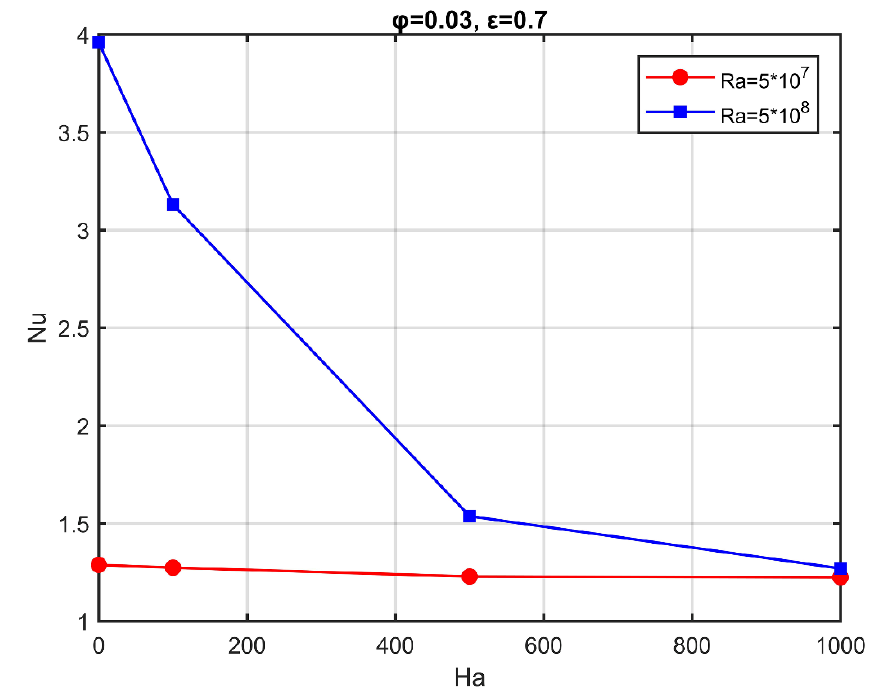
Figure 7. Average Nusselt number as a function of the Hartmann number, for characteristic Rayleigh numbers; ε = 0.7; ϕ = 0.03